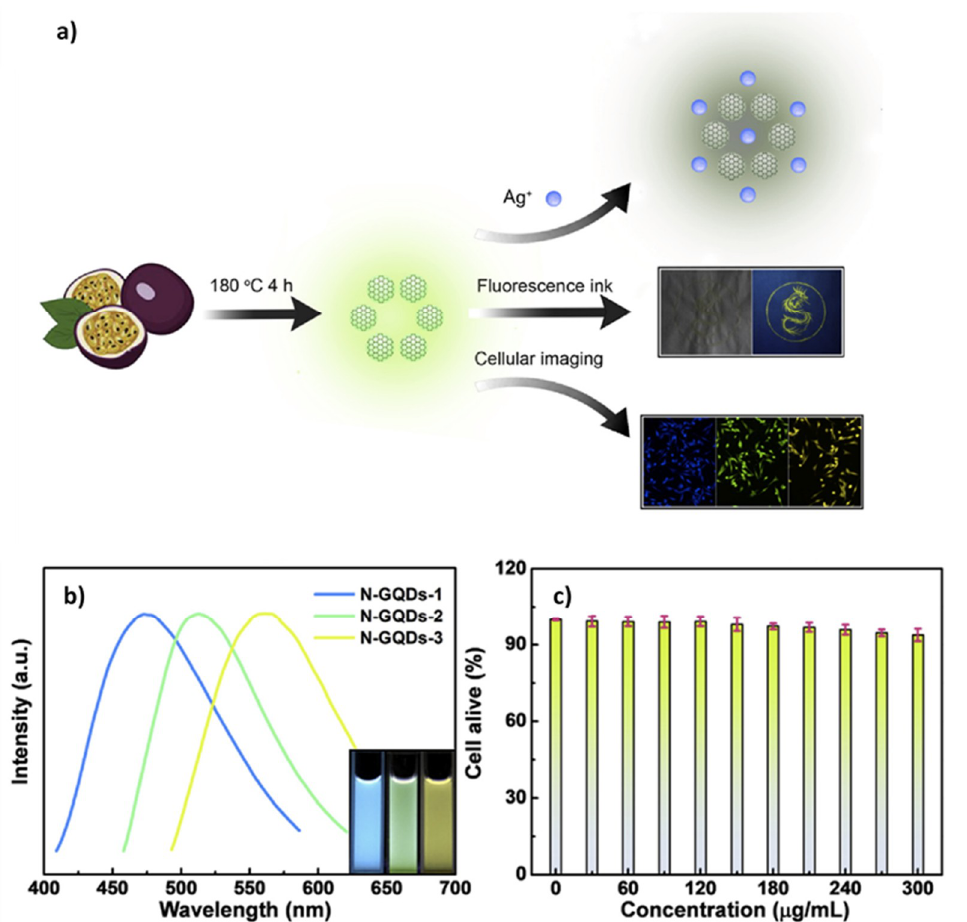
Figure 5. ( a ) Representation of the synthesis of N‐GQDs from Passiflora edulia Sims, followed by the biosensing, ink, and bio‐imaging applications. ( b ) The mechanism for the multicolor emissions of the N‐GQDs was performed under different wavelengths. Blue, green, and yellow emissions were obtained under 472, 509, and 565 nm, respectively. ( c ) The correlation between the increasing amounts of N‐GQDs and fibroblast cell viability [143].